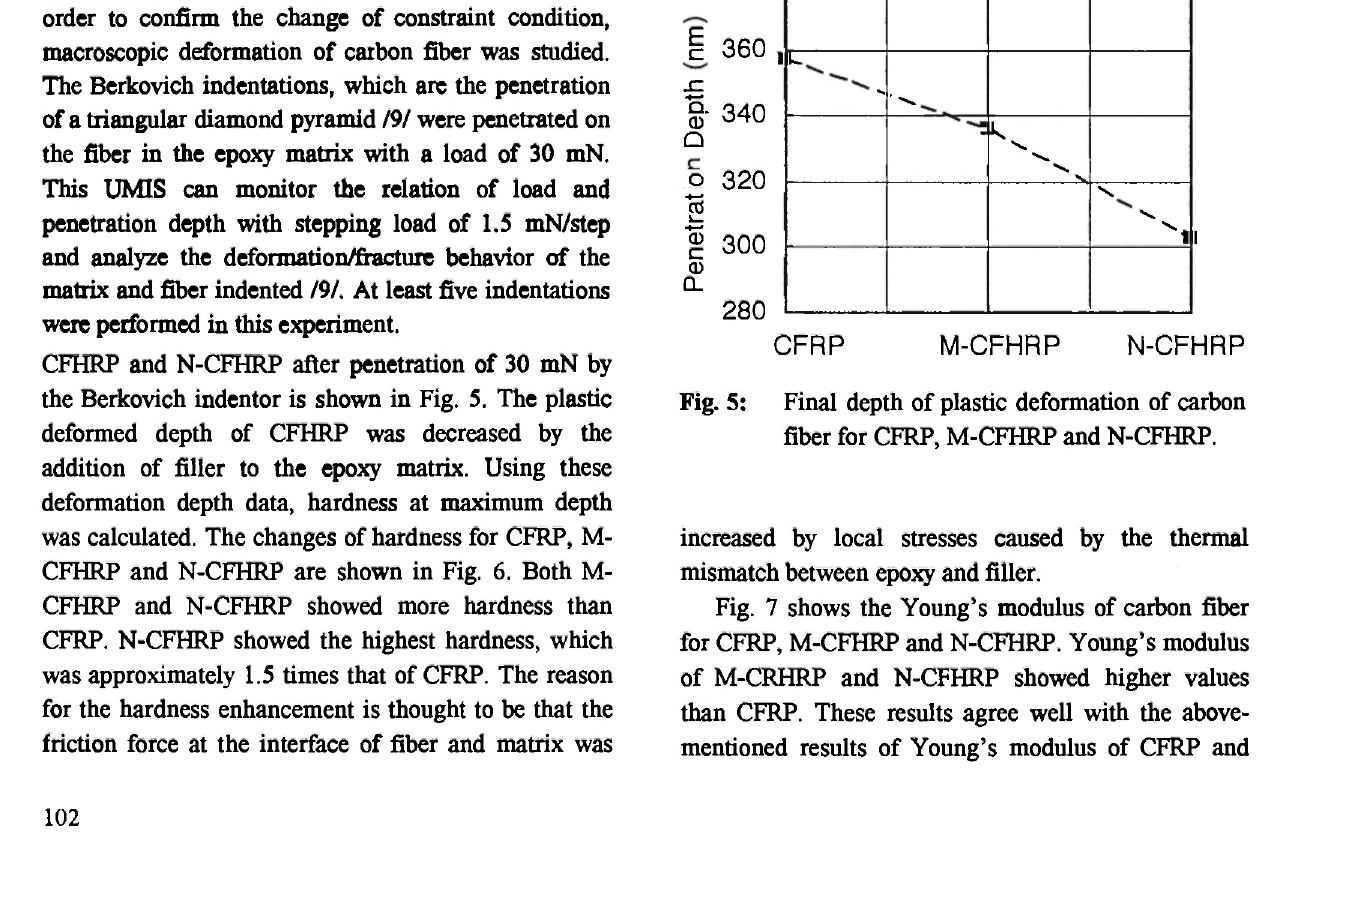
Fig. 4: Typical profile of penetration depth with increasing load indented by the Berkovich 191.